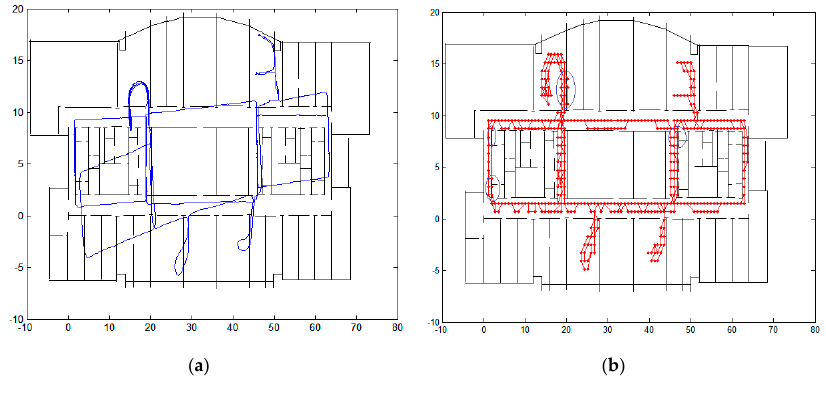
Figure 5. Comparison of trajectory carried out in another site by another person with ( a ) being the raw trajectory and ( b ) being the trajectory using